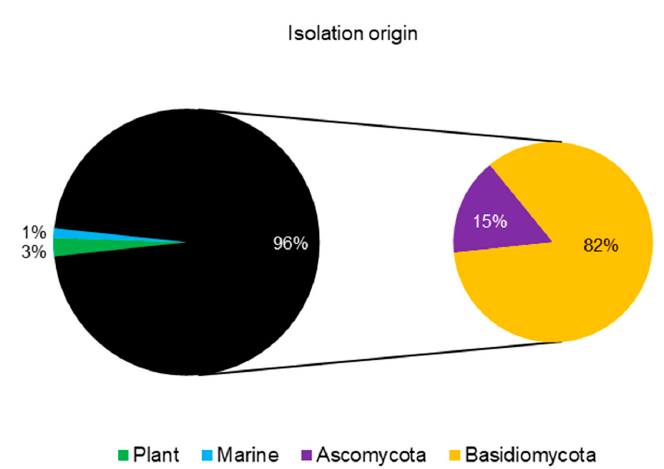
Figure 1. Isolation sources of protoilludane natural products.